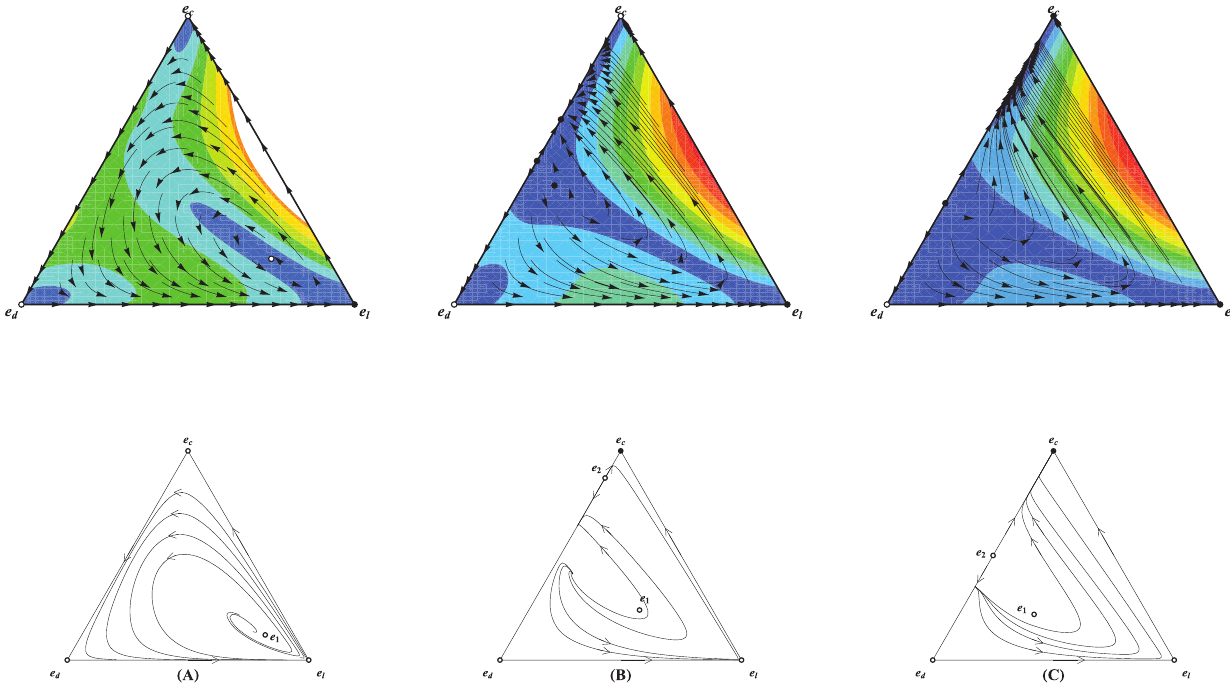
Figure 7. Triangle plots illustrating the population dynamics for defectors ( e d ), cooperators ( e c ) and loners ( e l ) for trajectories starting from all possible initial frequencies for the inverse-sigmoidal risk removal pattern. Each vertex represents a homogeneous population of that pure strategy. ( A ) For small interest rate r , all orbits starting from the inside area of S 3 converge to e l . ( B ) Moderate r delimits the inside area into two attraction basins. The equilibrium e 2 , a coexistence state of cooperators and defectors, accounts a relatively large area as its attraction basin. The rest of the inside area is the loner’s attraction basin. ( C ) Further increase in r makes the e 2 coincide with e c and its attraction area spreads almost the whole inside area. Relevant parameters N ~ 10 , m ~ 10 and ( A ) r ~ 3 , ( B ) r ~ 6 , ( C ) r ~ 10